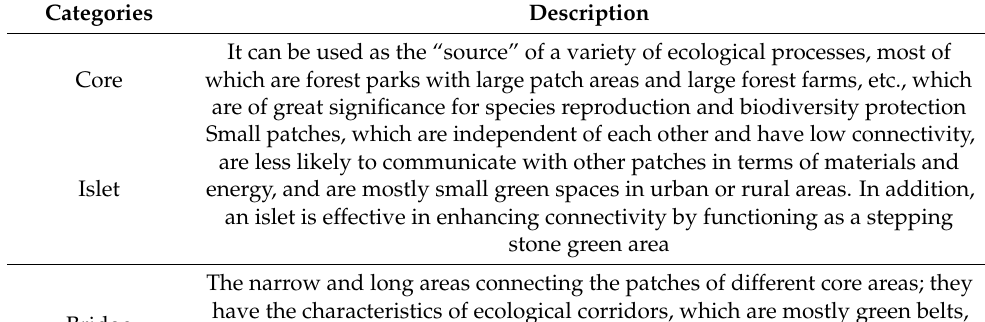
Table 1. Morphological spatial pattern analysis (MSPA) categories and ecological